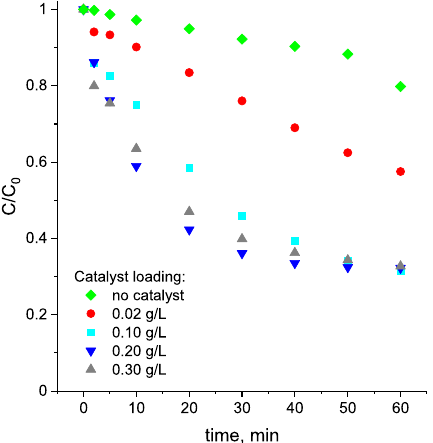
Figure 6. The influence of CePO 4 /CeO 2 dosage on the efficiency of ozonation recovery in the presence of chloride ions. Reaction conditions: 200 mL of BA solution (24 µM), initial ozone concentration: 120 µM, initial pH: 2.5, concentration of chloride ions: 3.22 mM, room temperature.